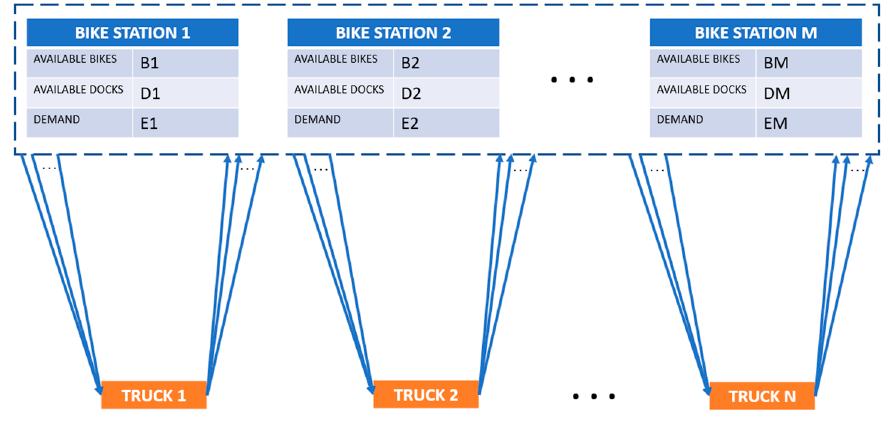
Figure 3. General rebalancing routing problem.